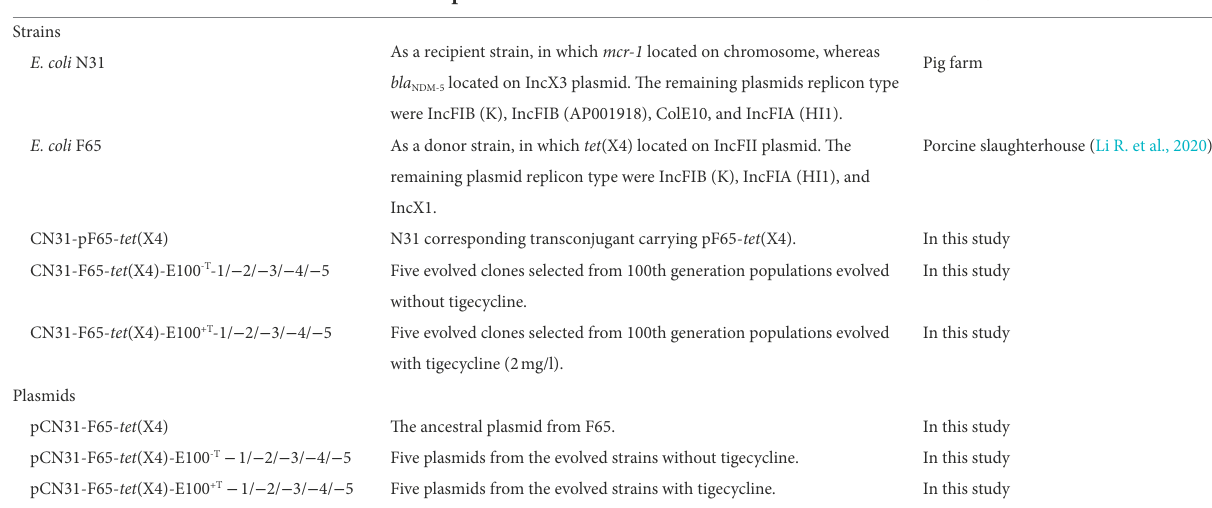
TABLE 1 Basic information of bacteria and plasmids used in this